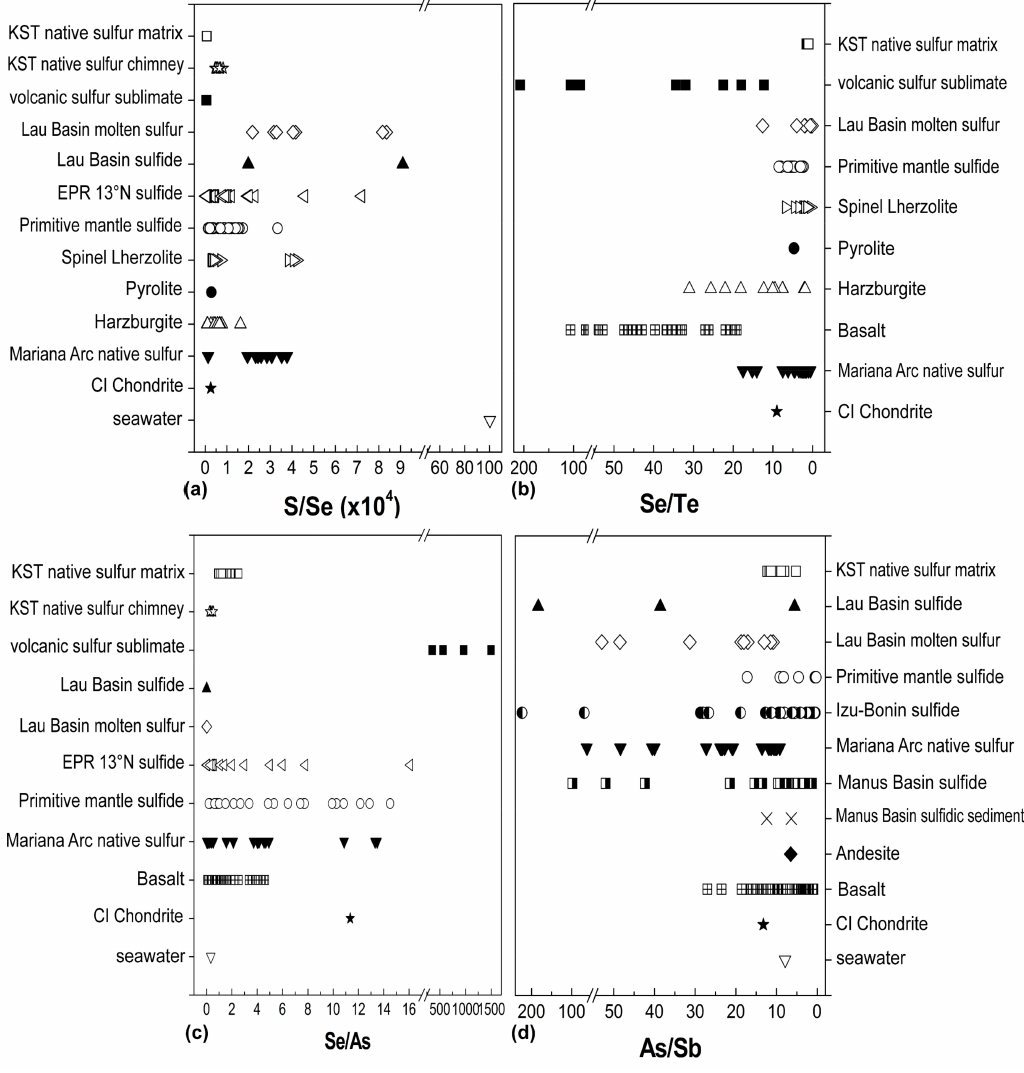
represents Lau Basin molten (cid:51) represents Primitive mantle (cid:35)